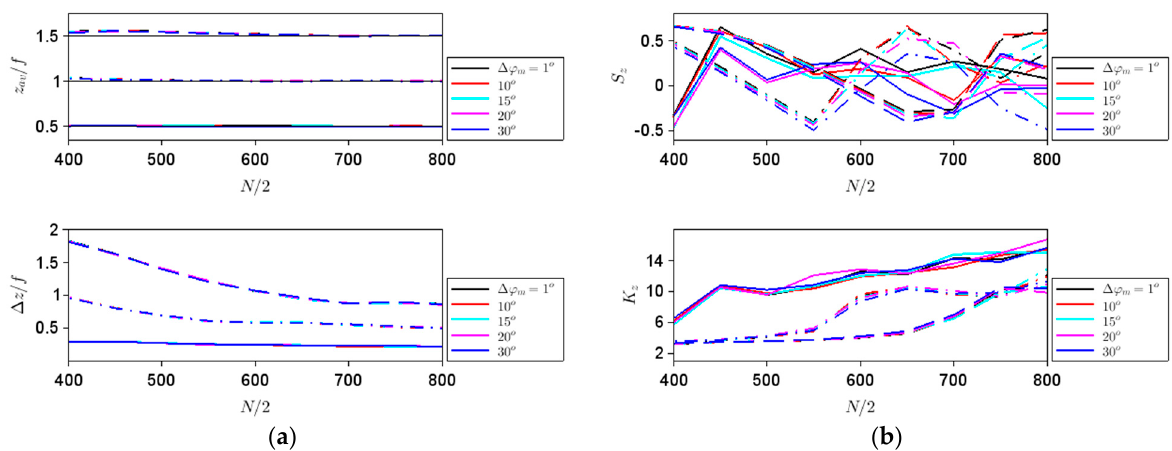
Figure 4. Dependences on the aperture size of ( a ) z av and ∆ z , and ( b ) S z and K z for different steps in ∆ φ m indicated in the legend and focal lengths of f /2 (solid line), f (dashed–dotted line) and 1.5 f (dashed line). The thin black lines in the top figure ( a ) represent the geometric location of the focal spot.